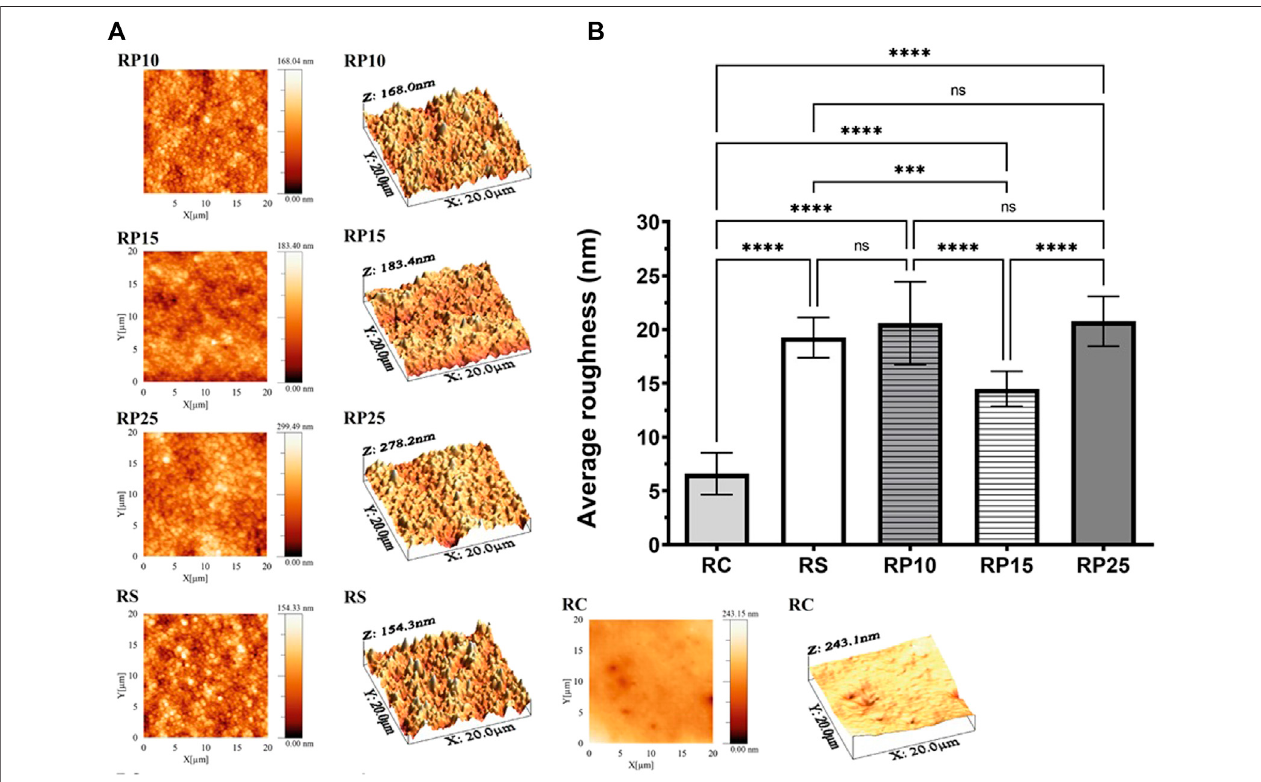
FIGURE 7 | Average roughness (Ra) of EABRP enriched composite resins. (A) : Topographic images obtained by AFM for experimental groups. (B) : Average roughnessvalues(Ra)forallresinsanalyzed.RC,commercialresin;RS,commercialresin+HEMAsolvent;RP10,RP15andRP25,enrichedEABRPcompositeresinsat 0.10, 0.15 and 0.25%